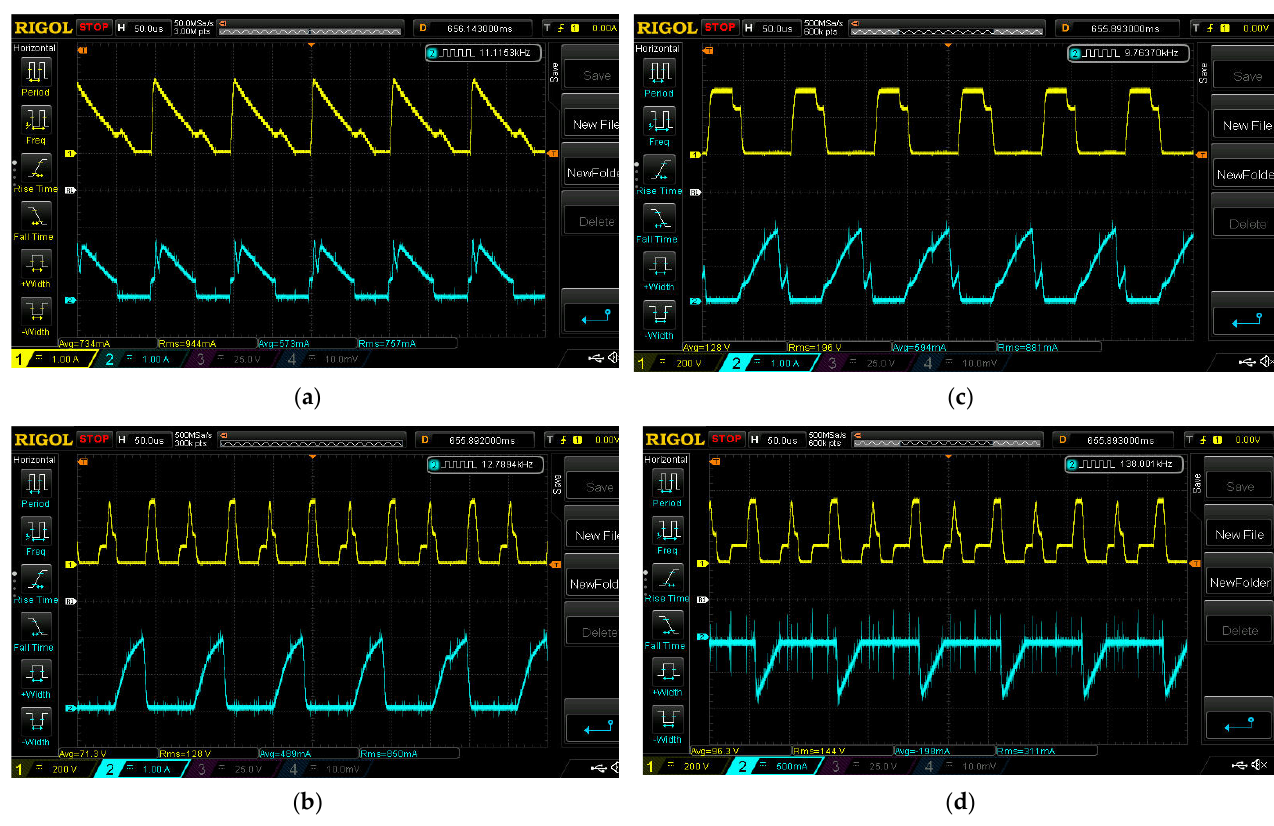
Figure 12. Experimental Wave Form of Switch and Diode in ESS Least Domain.